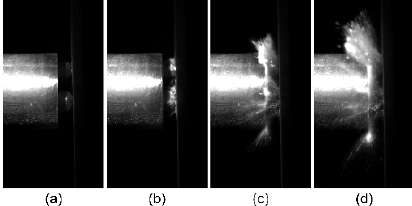
Fig. 6. (a) Dynamic indentation force as a function of time for a typical test; (b) the craters after the typical test; and (c) the fragments after the typical test.